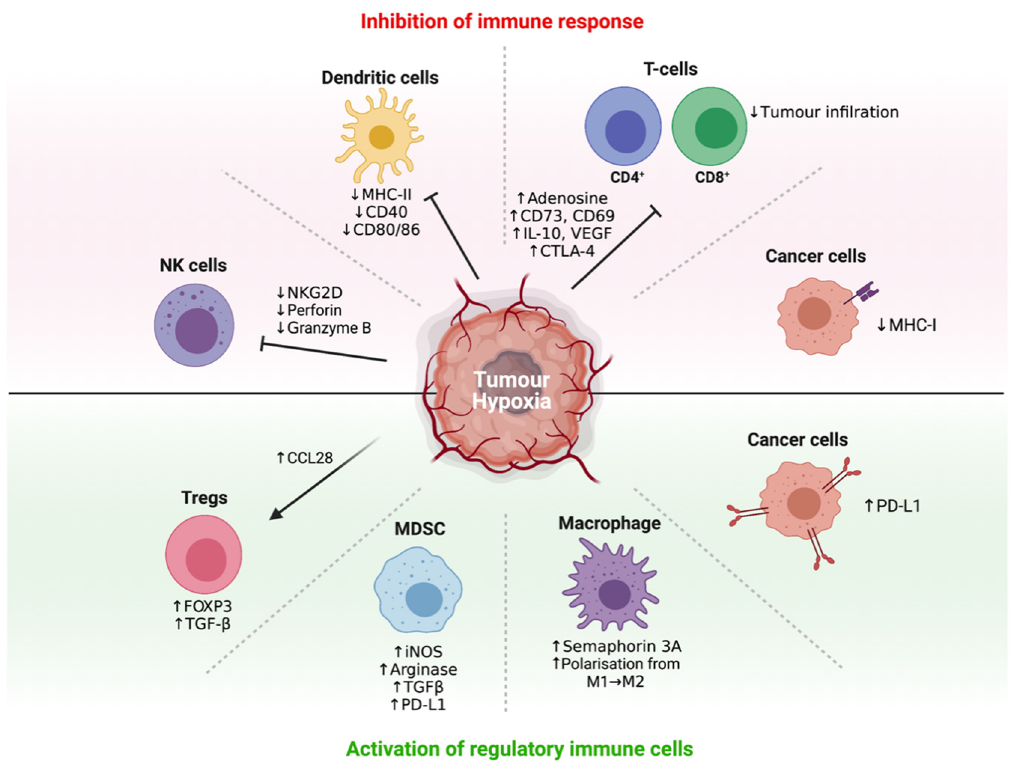
Figure 2. Regulation of immune response by tumour hypoxia. Different cell types by which tumour hypoxia influences in the tumour microenvironment.